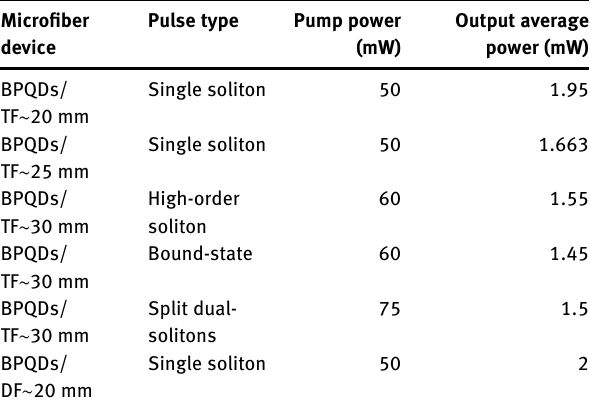
Table  : Powercharacteristics with differentmicro fi ber devicesand operation regimes. Micro fi ber